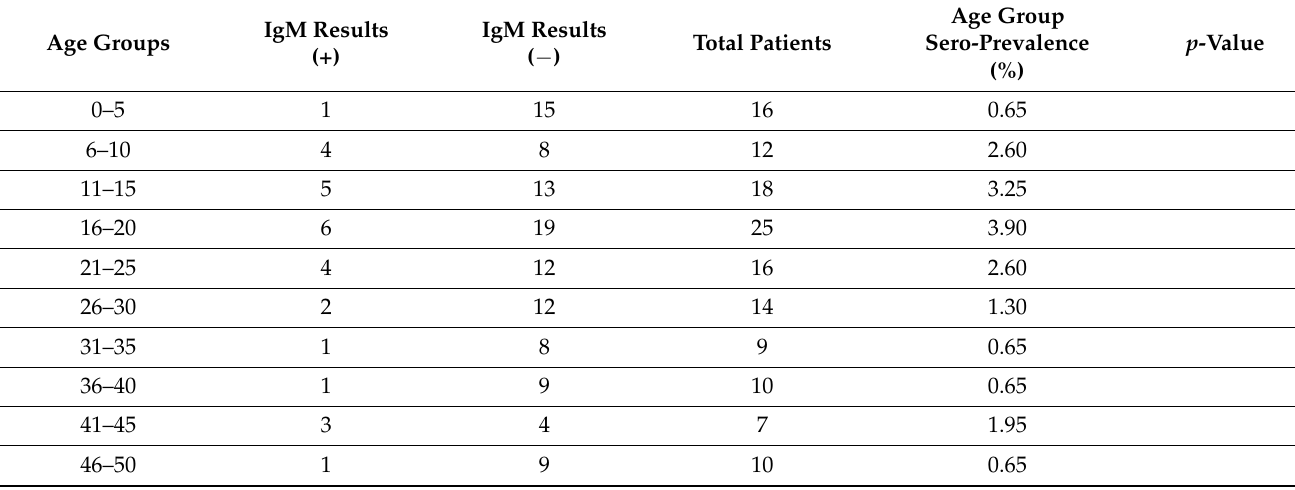
Table 5. Dengue virus infection detection among patients in Numan by age